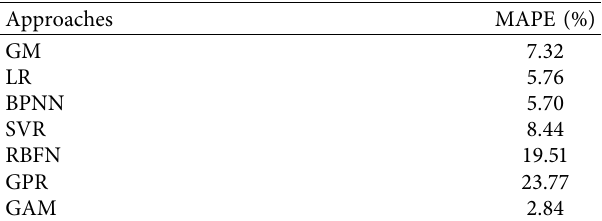
Table 3: Prediction performances among various approaches.